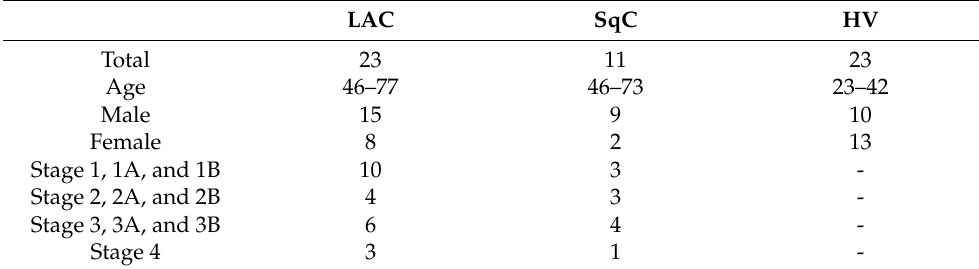
Table 1. Patient and healthy volunteer characteristics. LAC—lung adenocarcinoma, SqC—lung squamous cell carcinoma, and HV—healthy